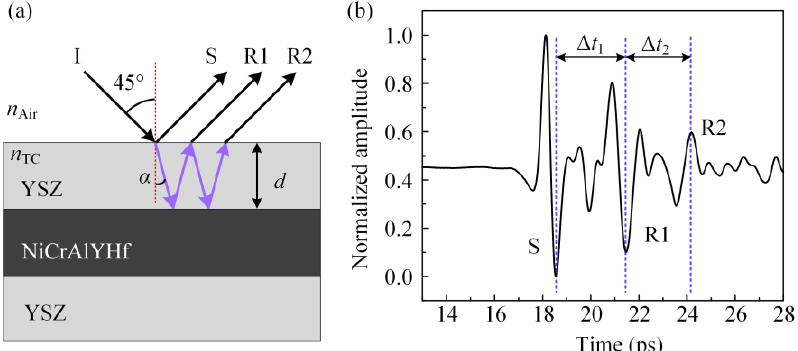
Figure 4. ( a ) The propagation path of a terahertz wave in specimens, ( b ) reflective terahertz time- domain spectrum.